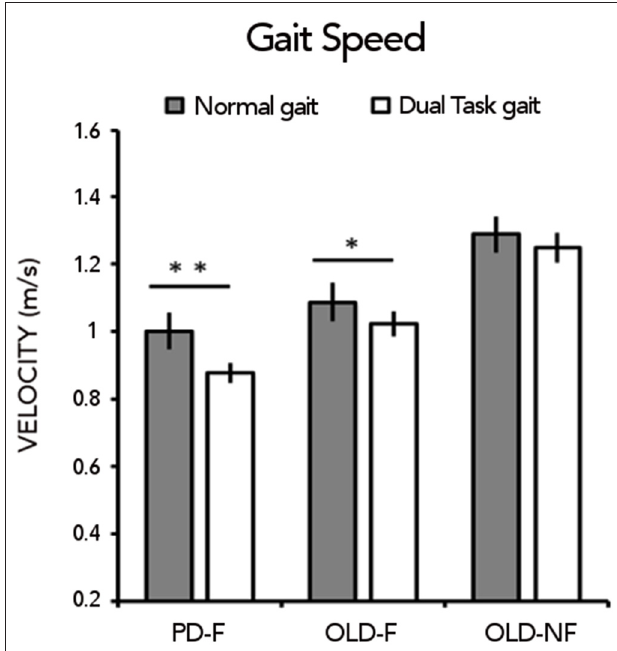
FIGURE 1 | Gait speed (m/s) under normal gait and dual task gait in the three groups of subjects (Parkinson’s Disease fallers, PD-F; Older adults fallers, OLD-F; Older adults non-fallers, OLD-NF). Asterisks indicate statistical significant difference within group between normal and dual task gait ( ∗ p < 0.05, ∗∗ p <